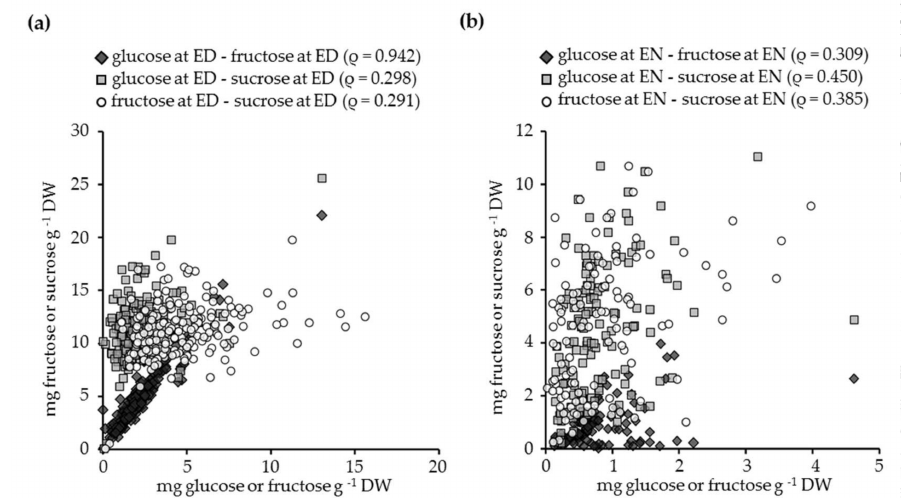
Figure 3. Relationship between individual diel leaf WSC contents in 185 individual genotypes sampled ( a ) at ED and ( b ) at EN. The corresponding p -values to the Spearman-rank correlation coefficients ( (cid:36) ) are indicated in the text. Measurements for glucose, fructose, sucrose, and starch contents were the same as described in Figure 1.